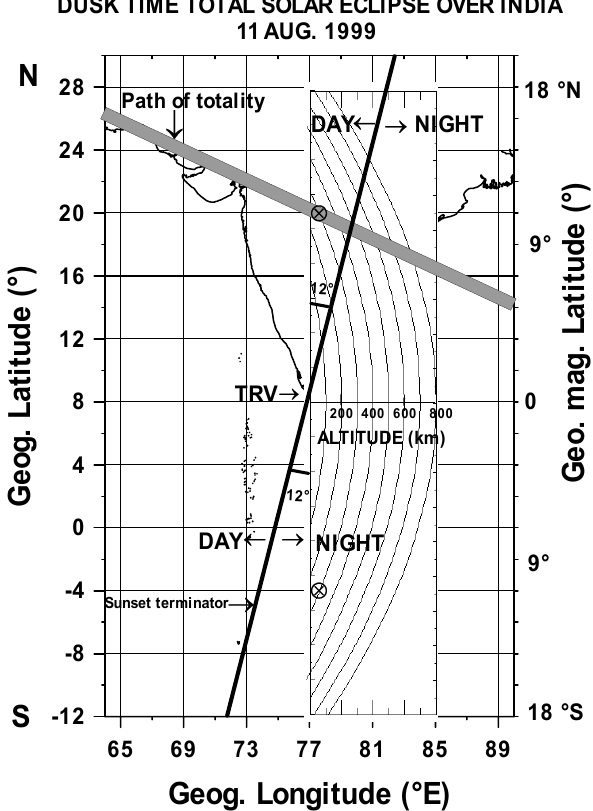
Fig. 7. The possible scenario on the eclipse day illustrating how the magnetically conjugate E-region (encircled cross) in the horizontal plane traversed by the eclipse path (shaded area) over India is linked to the 250–300km region of the F-layer over the equatorial location of Trivandrum where the other magnetically conjugate E-region is well in the